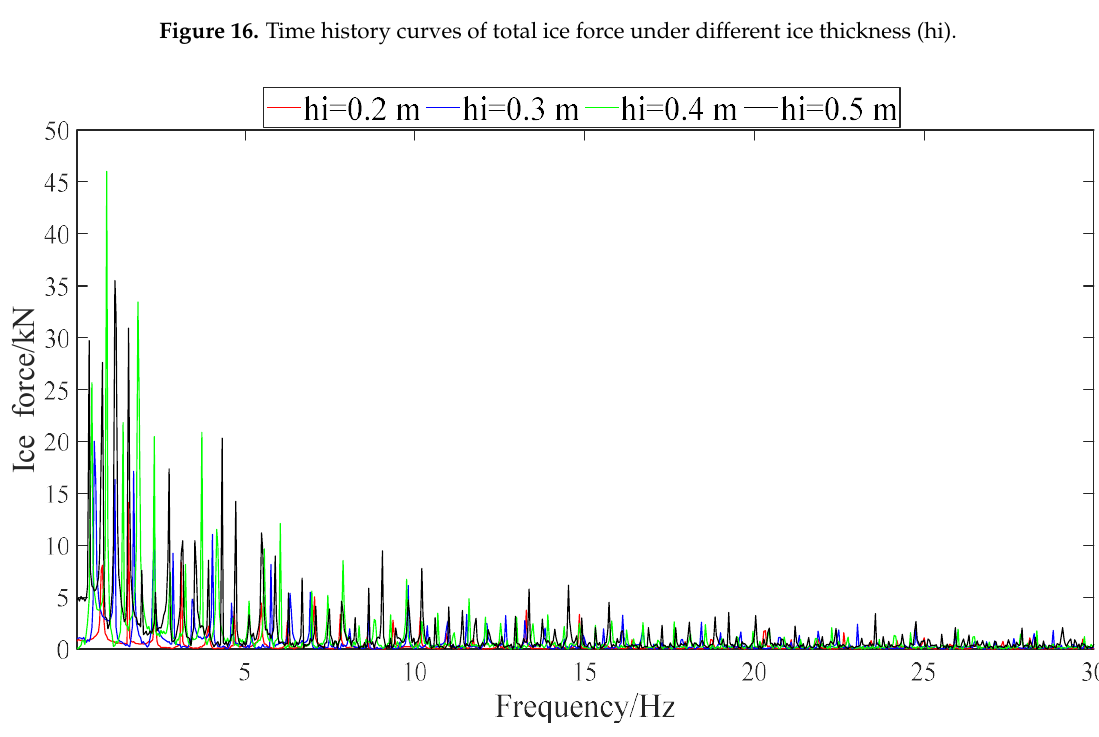
Figure 17. Frequency domain curves with different ice thickness (hi).